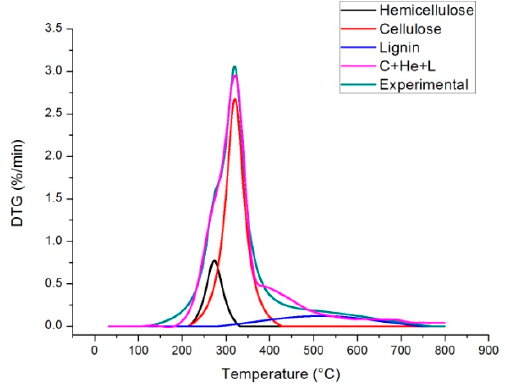
Figure 6. Peak deconvolution result (Heating Rate 5°C/min).